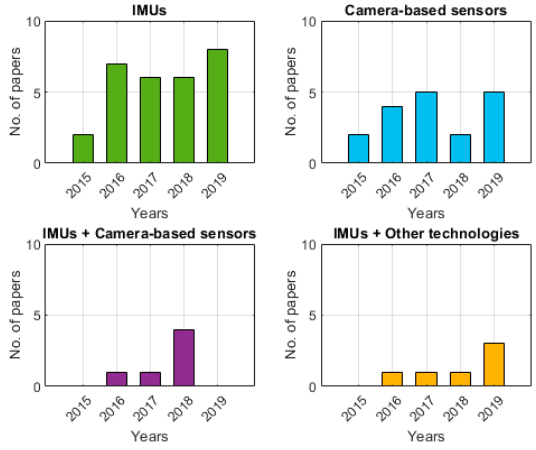
Figure 2. Number of publications per year divided by type of MoCap technology adopted. Table 3. Sensors used in the reported studies.